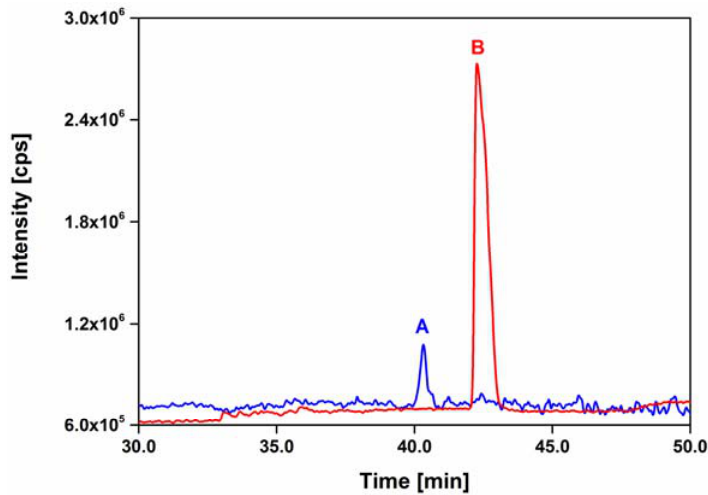
Figure 1. Electropherogram of bis(trifluoromethanesulfonyl)imide (TFSI − ) with the buffers A (40.0 mM ammonium formate buffer) and B (50.0 mM ammonium acetate buffer).